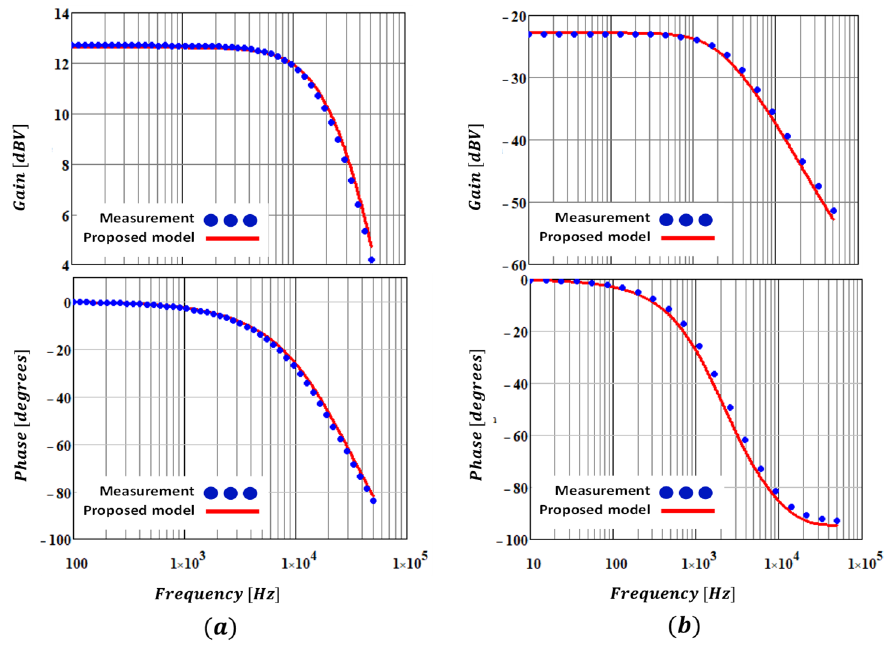
Figure 19. Frequency response of control to output voltage transfer function. ( a ) 8.5 W. ( b ) 70 W.